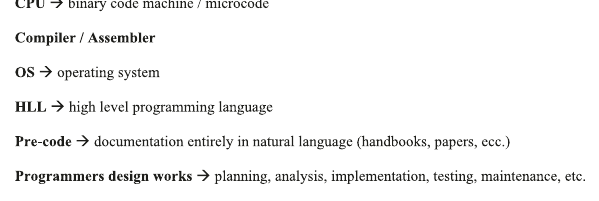
Fig. 1 The different layers that compose a software system. Some layers are material, others immaterial; some are visible, others invisible. From top to bottom the